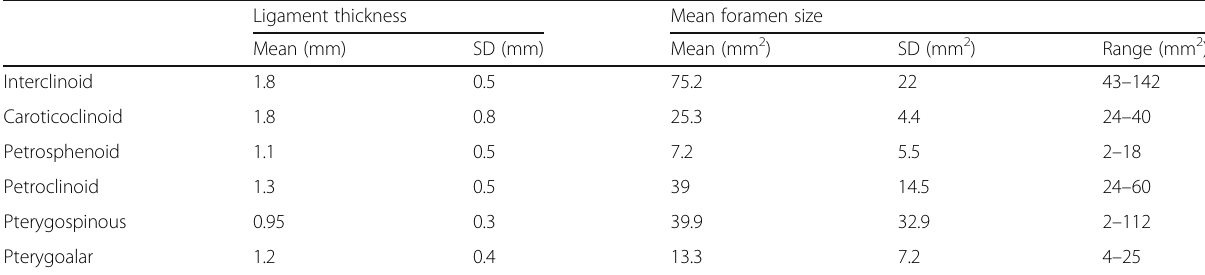
Table 4 Ligament thickness and foramen size Ligament